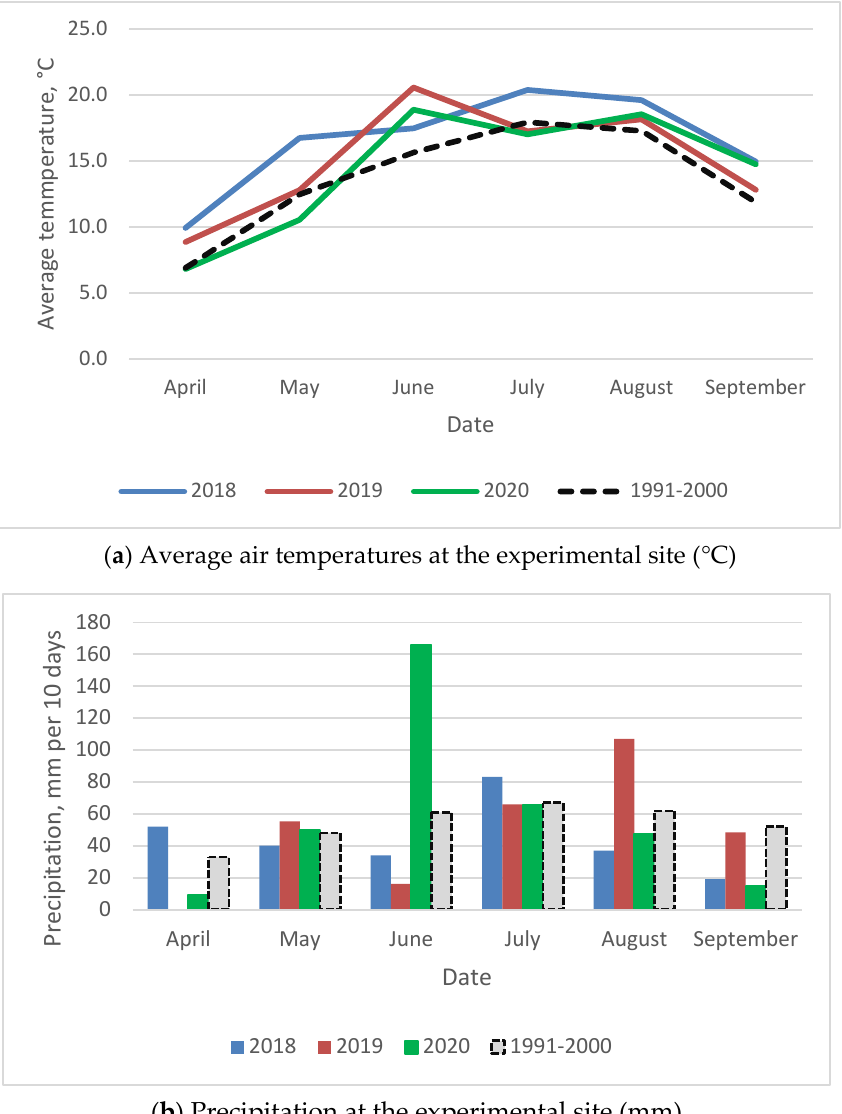
Figure 1. Meteorological conditions from 2018–2020 in Akademija.